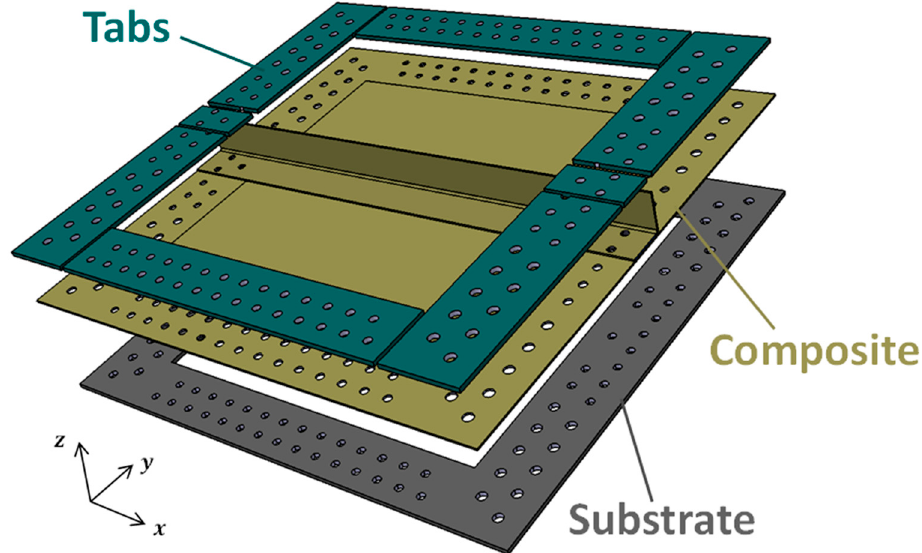
Figure 6. Exploded view of the parts considered, thanks to CAD of actual parts.